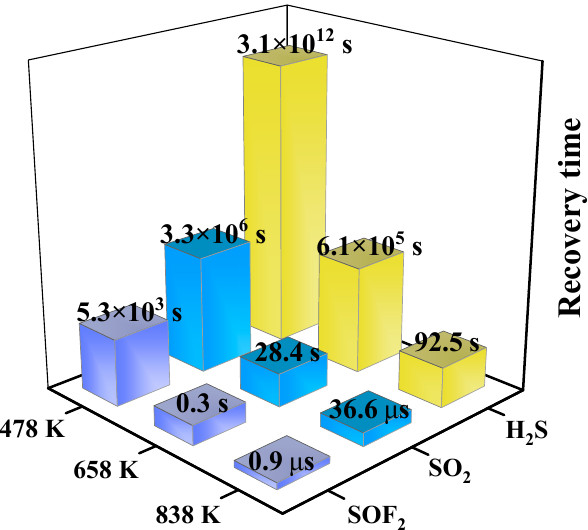
Figure 12. The predicted recovery time of various optimized systems.